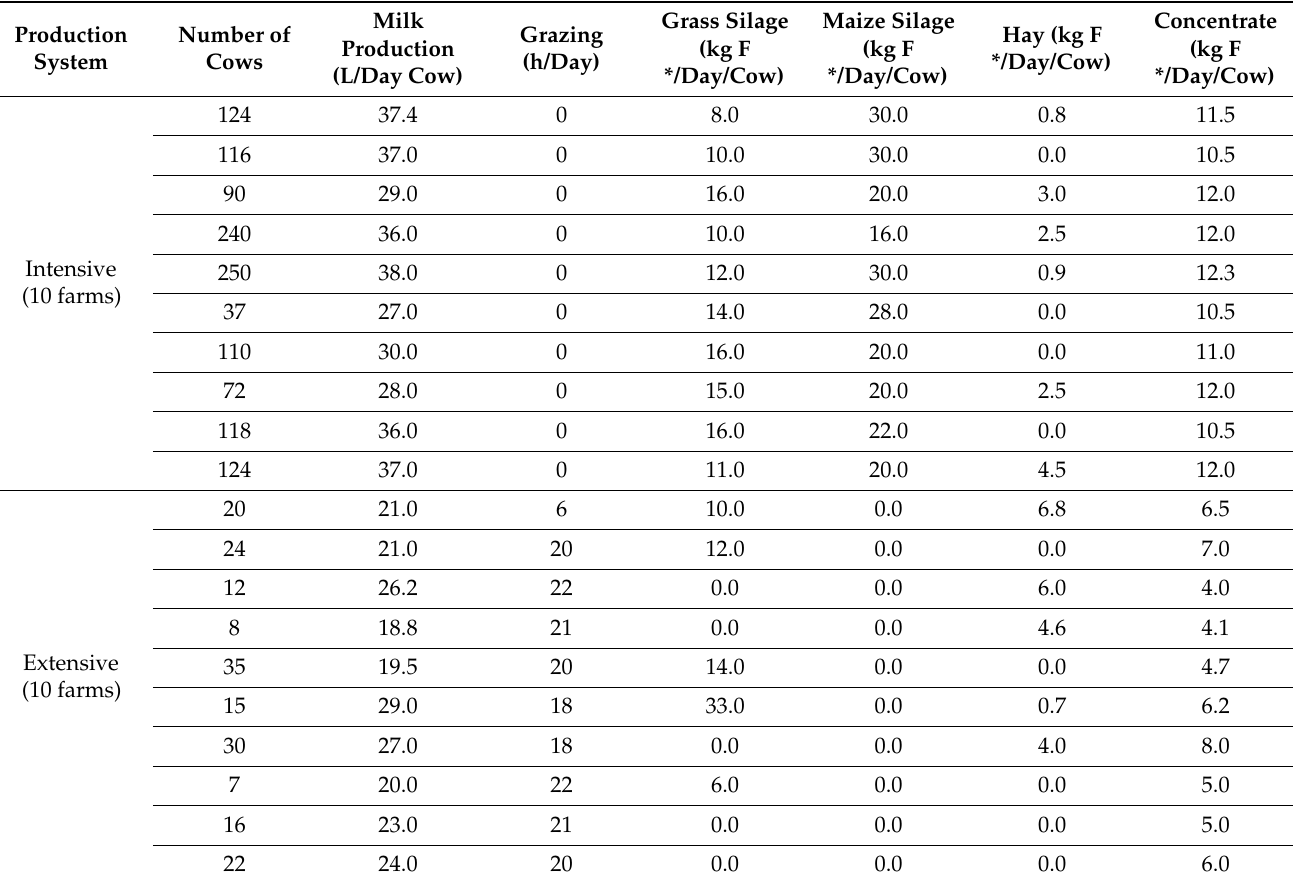
Table 2. Characteristics and diet from twenty dairy farms featuring extensive or intensive production systems, where milk was sampled for quantitative real-time PCR